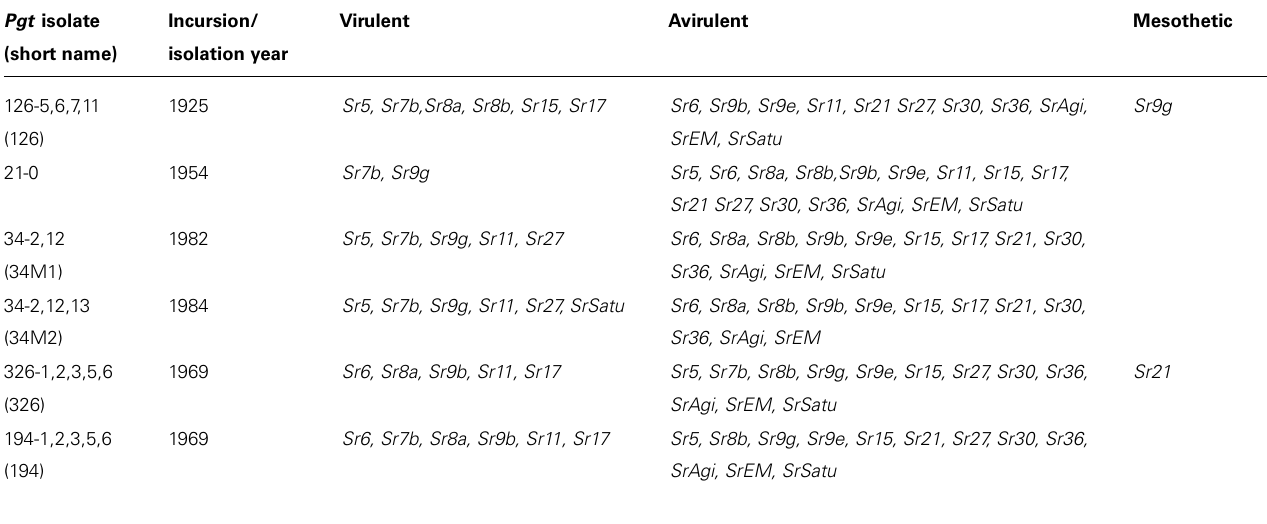
Table 1 |Australian Pgt isolates used in this study and their compatibility ( Avr / avr profiles) with different host R genes. Pgt